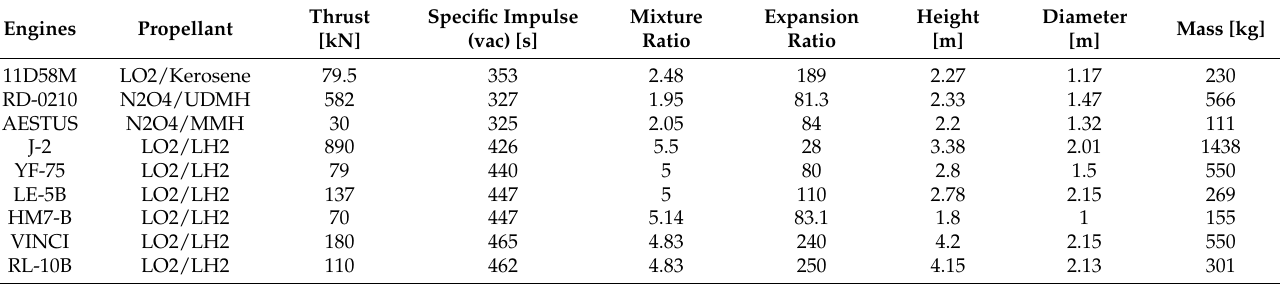
Table 2. Engines of the last stages [21–24].